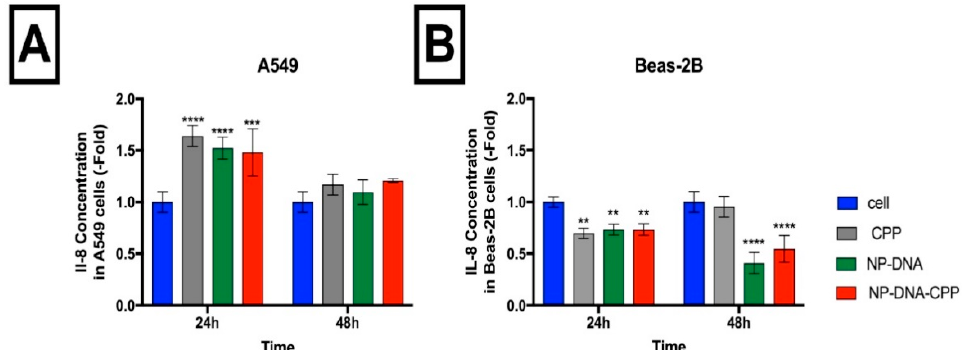
Figure 6. Effect on the pro-inflammatory cytokine IL-8 after 24 and 48 h of exposure to NPs coated (NP–CPP) or without (NP), and CPP alone for both: ( A ) A549 cells, and ( B ) Beas-2B cells. All treatments were compared to the non-exposed cell control (blue) using 2-way ANOVA. ( n = 3; ** p < 0.01; *** p < 0.001; *** p < 0.0001) followed by Tukey’s Test.